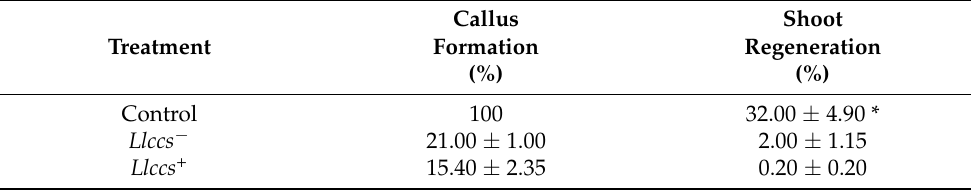
Figure 2. Morphogenetic response of uninoculated hypocotyl explants of V. cornuta to different concentrations of hygromycin after two and seven days of preculture. ( a ) Callus formation on hypocotyl explants; ( b ) Shoot development; ( c ) Average number of developed shoots/hypocotyl explant. The data represent mean values ± standard error. Mean values on different concentrations of hygromycin within the same preculture treatment are compared and marked with different letters when significantly different based on the Fisher’s LSD test ( p ≤ 0.01). Table 3. Regeneration of control, Llccs − and Llccs + transgenic V. cornuta hypocotyl